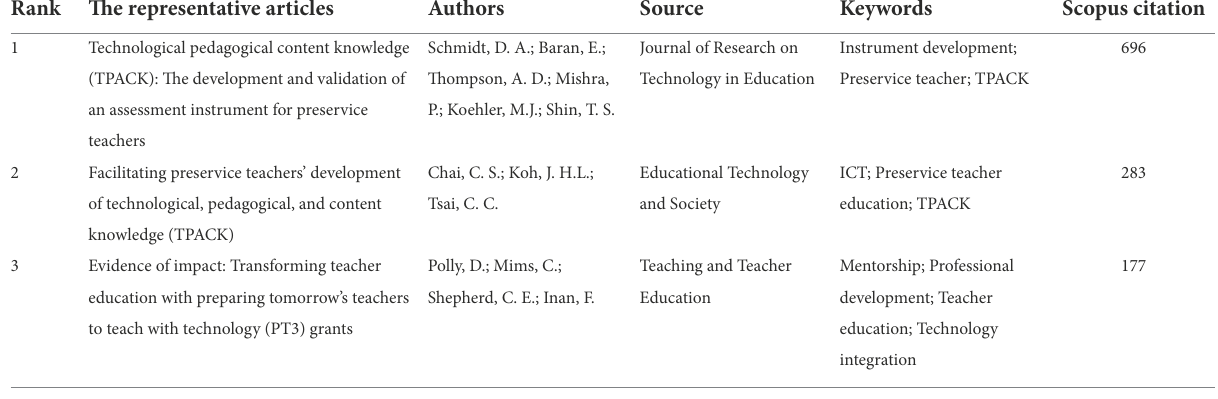
TABLE 3 Most contributing journals.